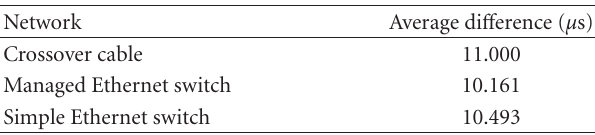
Table 9: Di ff erence between query and response times for di ff erent networking equipment, in